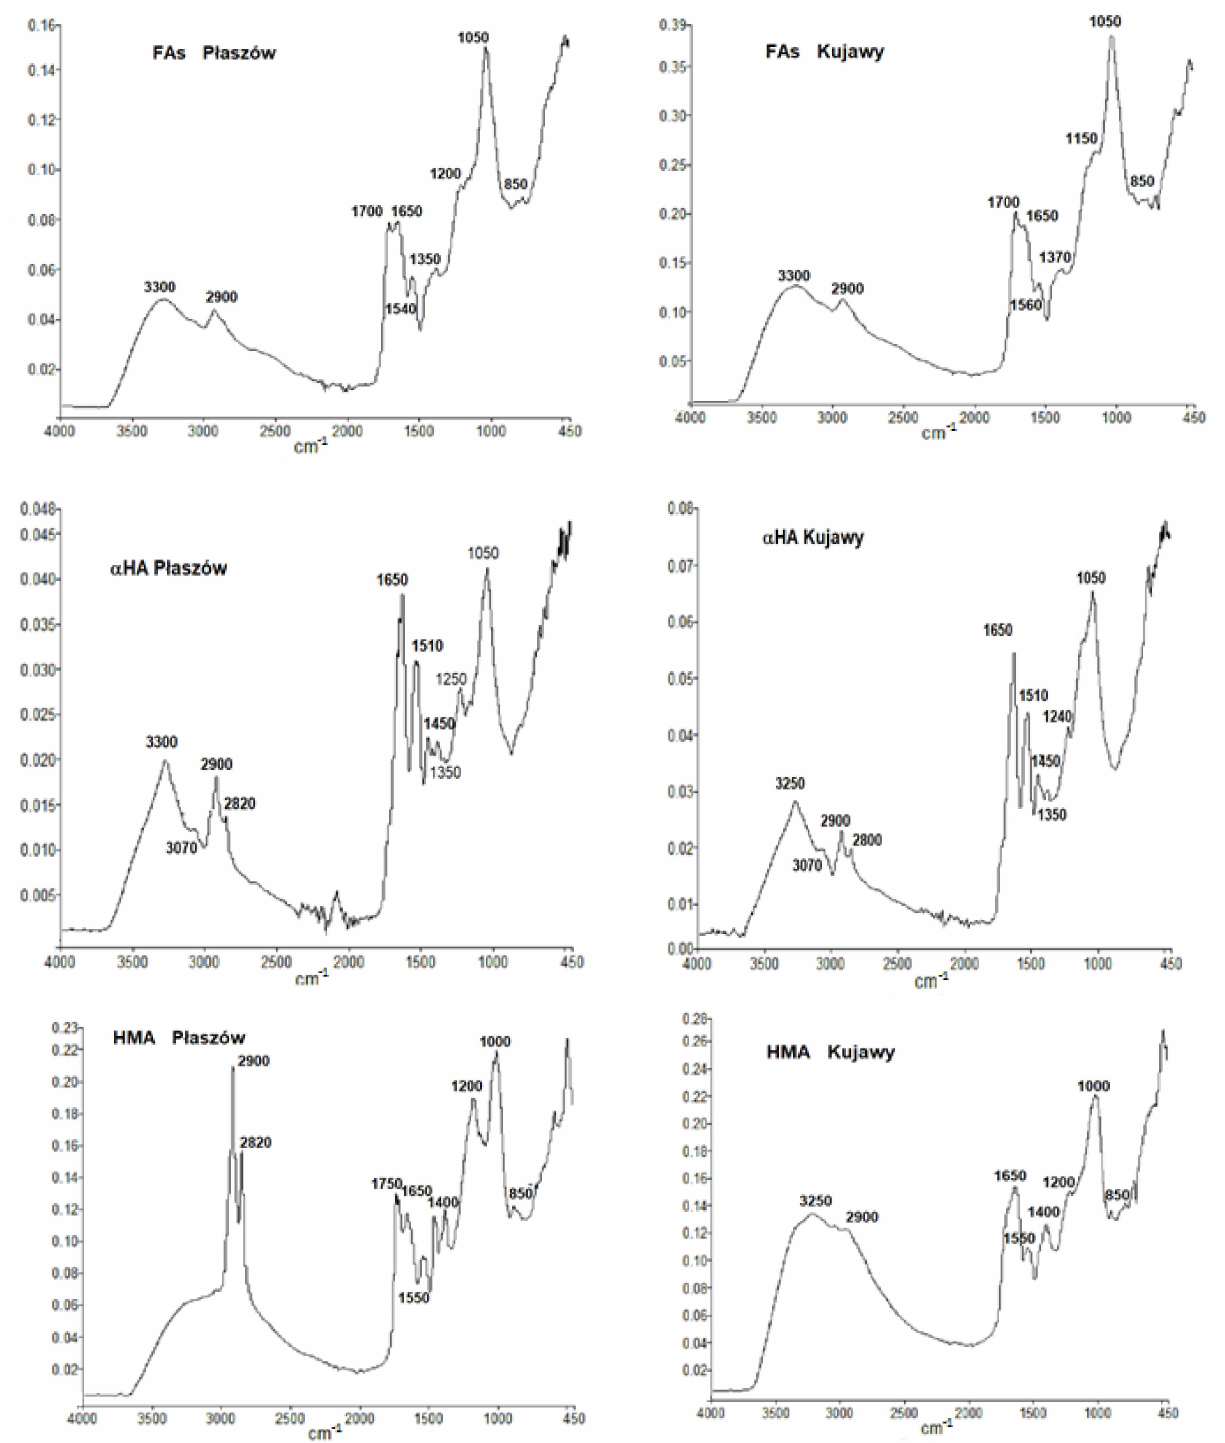
Figure 1. Infrared (FTIR) spectra HAs were recorded from digested sludge of the Płasz ó w plant: